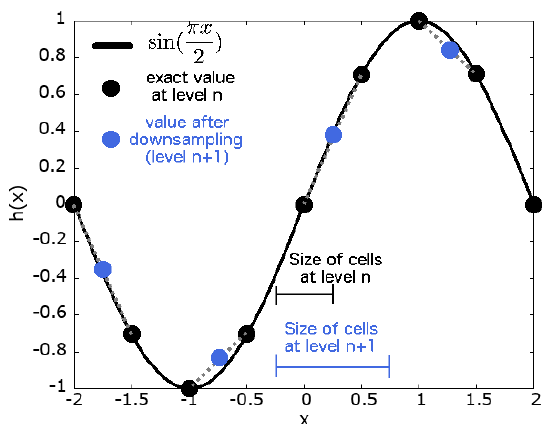
Figure 1. Passing from level n to level n + 1 (downsampling method).